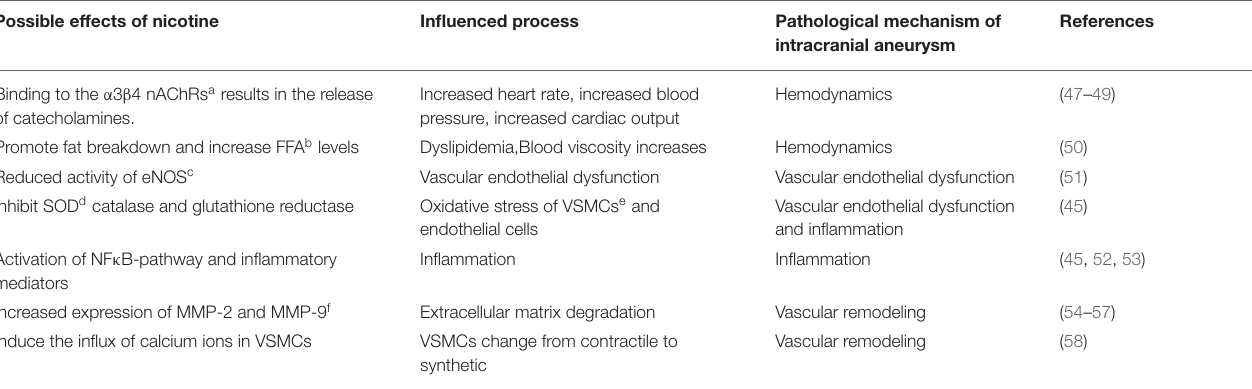
TABLE 4 | Nicotine may affect the pathological mechanism of intracranial